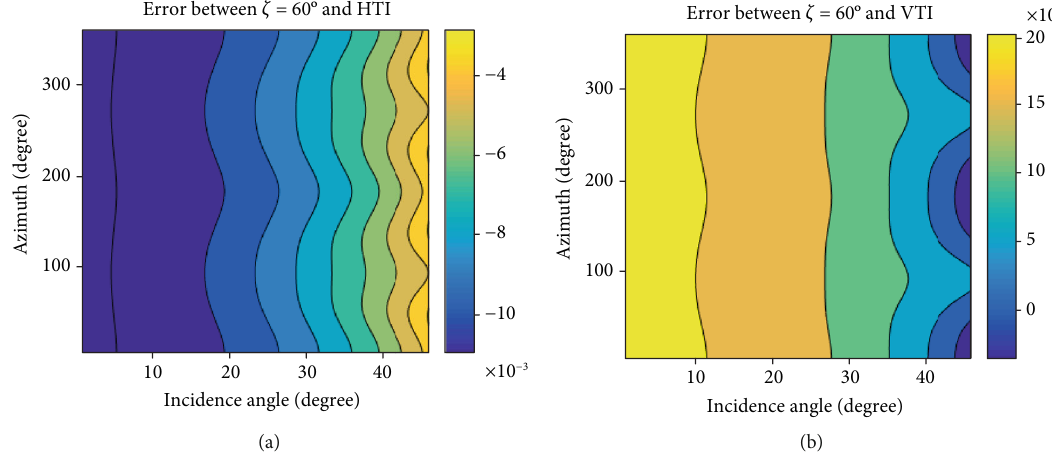
Figure 4: The relative error in PP-wave re fl ection coe ffi cient if a TTI medium with dip of symmetry axis is modelled as an (a) HTI medium or a (b) VTI medium.